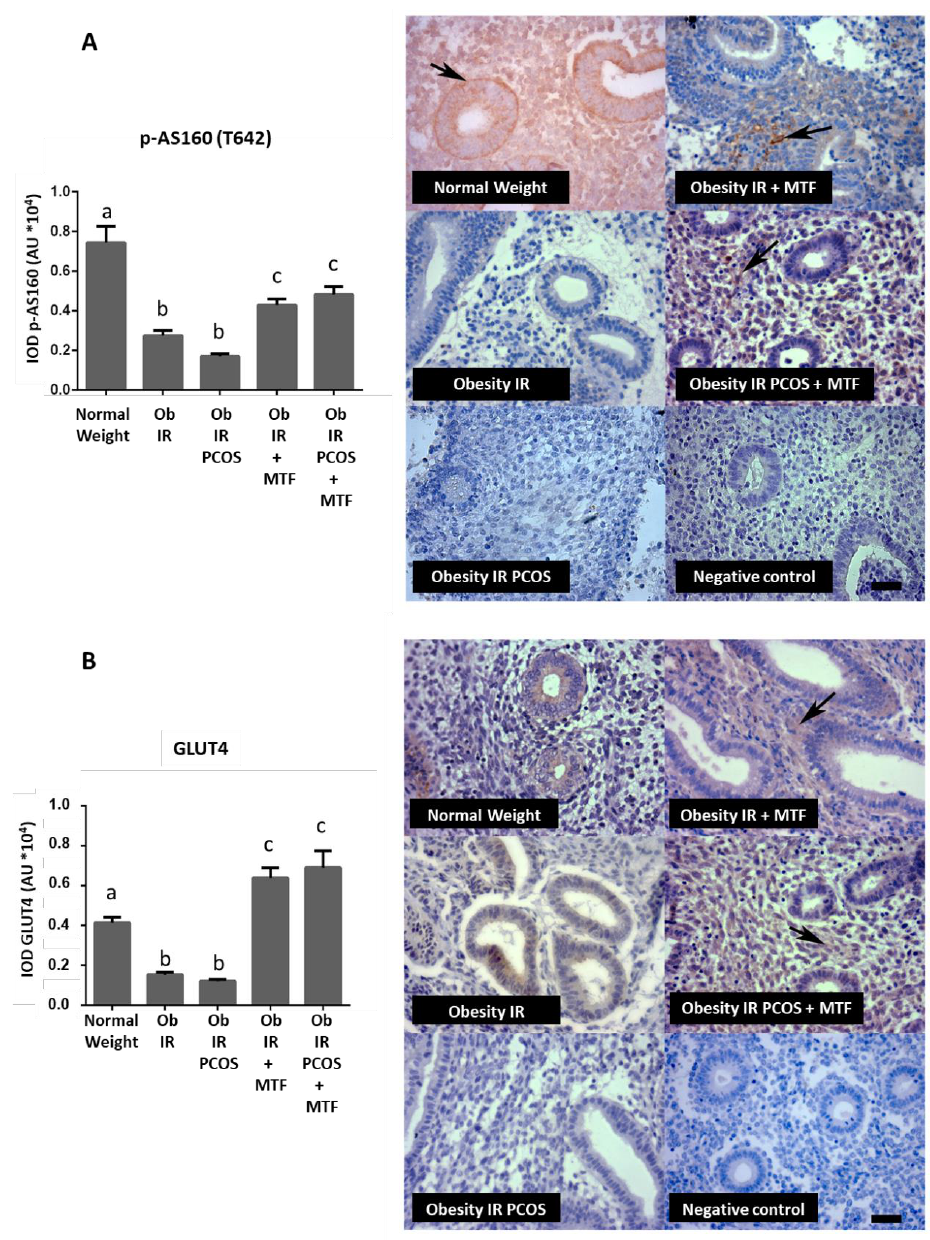
Figure 1. Effect of metformin on expression levels of molecules associated with insulin signaling in endometria from women with insulin resistance, obesity and PCOS. p-AS160 (T642) ( A ) and GLUT4 ( B ) levels in endometria from the study groups were determined by IHC ( n = 7 samples in each group): Normal Weight group (control group), Obesity + IR group, Obesity + IR + PCOS group, Obesity + IR group treated with metformin (MTF) and Obesity + IR + PCOS group treated with MTF. MTF treatment: 850 mg twice a day for at least 12 weeks. Photomicrographs show the tissue location of p-AS160 (T642) (in ( A )) and GLUT4 (in ( B )) by immune-positive brown color staining in each sample (arrows). The graphs show the semi-quantification of each protein level in endometrial tissue obtained by the IOD tool. Negative control: tissue samples in the absence of primary antibody. Bar = 50 µ m; images at 400 × . In the graph, a (cid:54) = b (cid:54) = c indicates a statistically significant difference with a p -value < 0.05; non-parametric test and Dunn’s post hoc test. Data are shown as mean AU (arbitrary units *10 4 ) ±